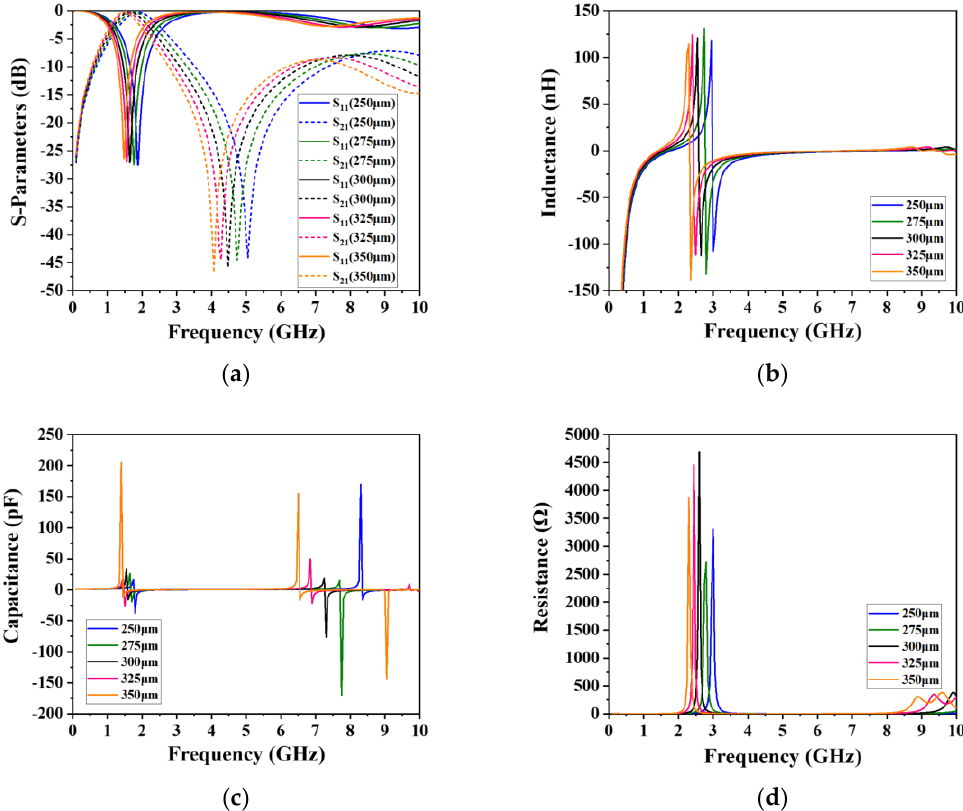
Figure 5. Simulated results illustrating the influence of the inner radius on the respective relationships between S-parameter and lumped parameters and frequency. ( a ) Simulated S-parameters, ( b ) simulated inductance, ( c ) simulated capacitance, and ( d ) simulated resistance.